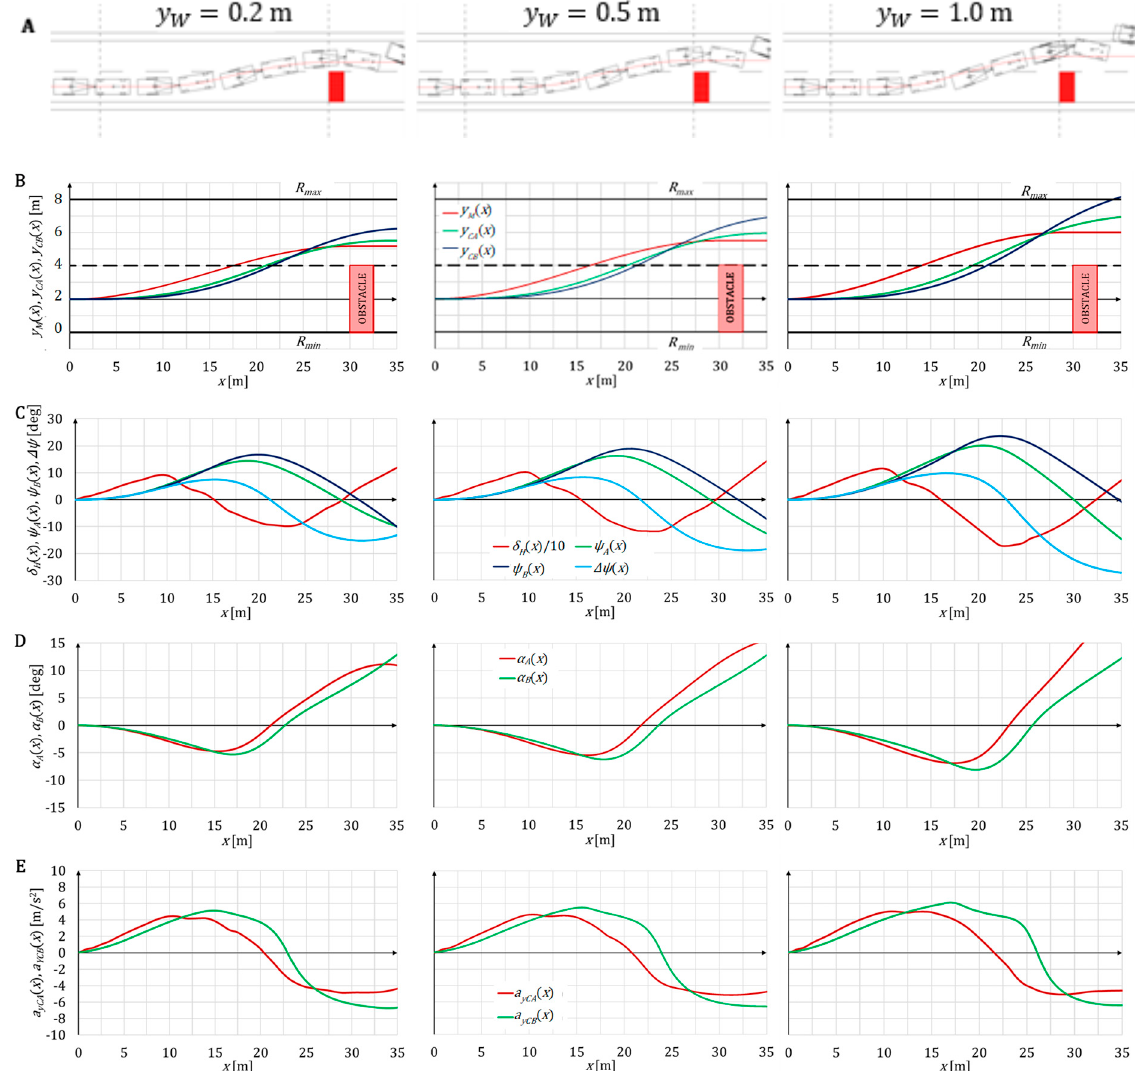
Figure 19. Curves representing selected physical quantities for the cosine trajectory planning method, L a = 6 m, v = 60 km/h, dry road surface, and three clearance margin values y W (individual columns): ( A ) CT unit’s motion animation; ( B ) path planning trajectory y M ( x ) and vehicles center of mass trajectory y Cs ( x ) ; ( C ) steering wheel angle δ H ( x ) , yaw angle ψ A ( x ) , trailer drawbar turning angle ∆ ψ ( x ) ; ( D ) tire sideslip angles for the rear axle of vehicles α s ( x ) ; ( E ) lateral acceleration of vehicles center of mass a yCs ( x )